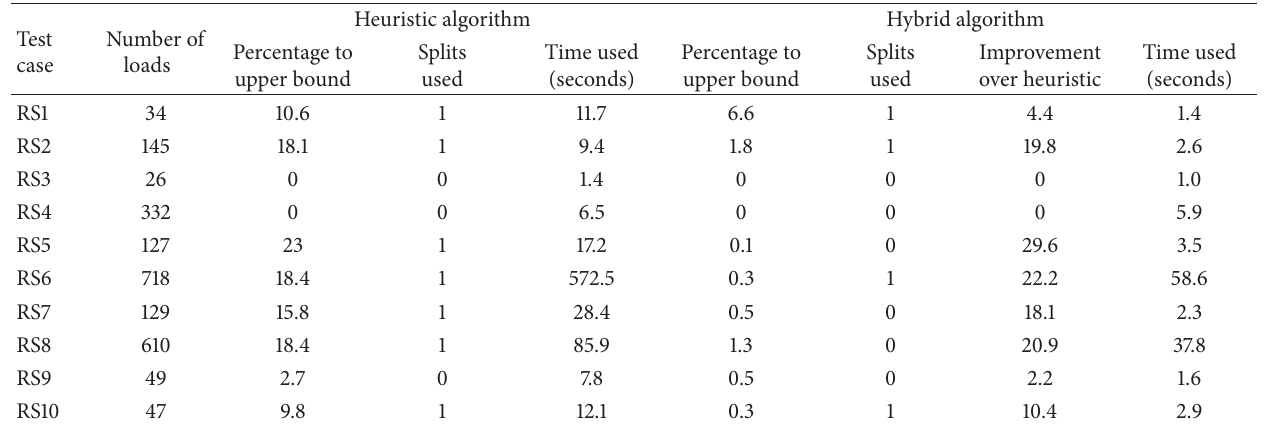
Table 4: Result of test cases with 1 split